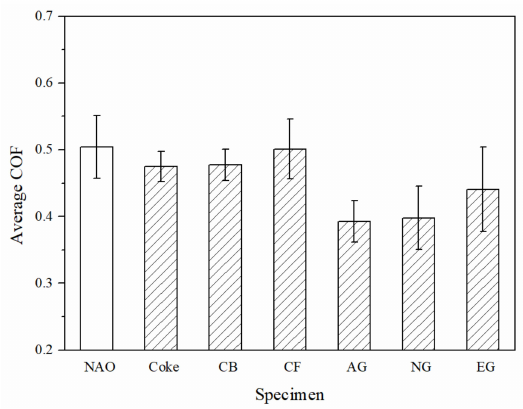
Figure 6. The average COF of specimens.